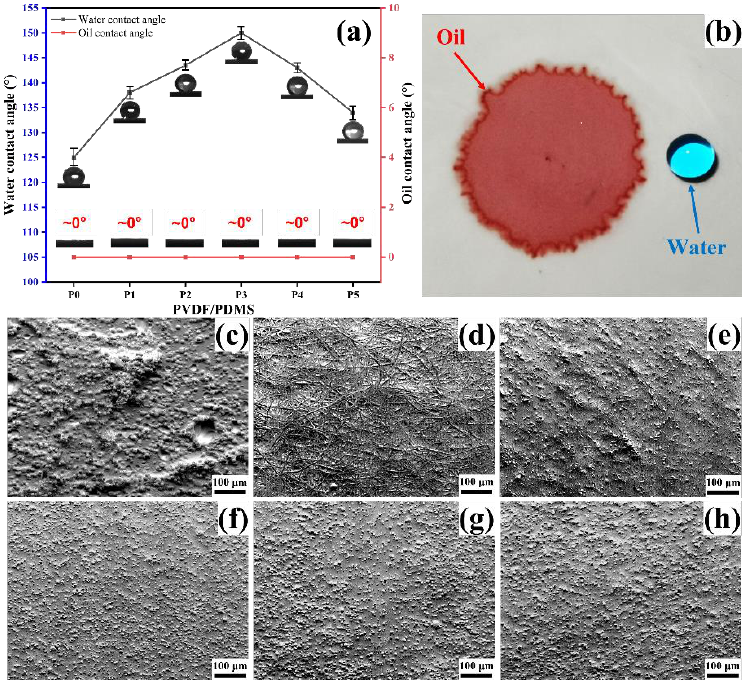
Figure 5. The wettability and micro-roughness of the membrane surface. ( a ) Water and oil contact angles of membranes P0 – P5. ( b ) Water droplets and oil droplets showed opposite wettability on the membrane. ( c – h ) Micro-roughness of membrane P0 – P5.